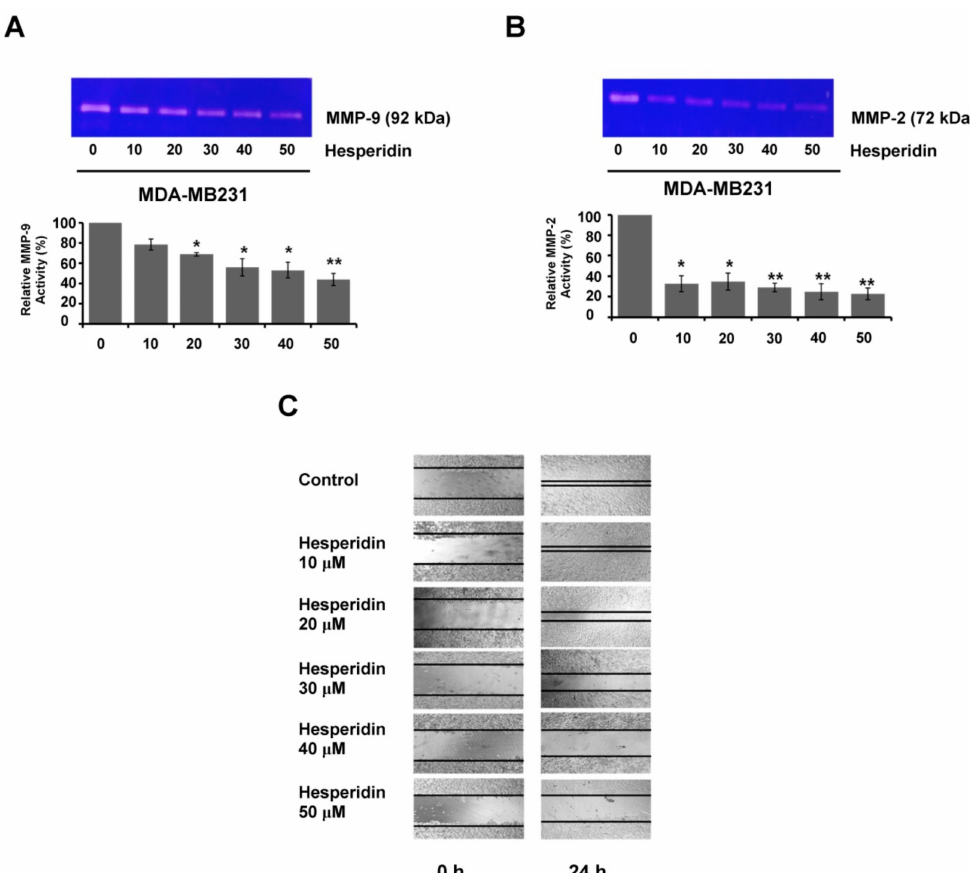
Figure 5. Hesperidin suppressed the migration and MMP secretion in PD-L1 high-expressing MDA-MB231 cells. The relative activities of ( A ) MMP-9 ( B ) MMP-2. Bar diagram represents the relative activity of MMPs in hesperidin treated groups compared to the control group considering the control value as 100 percent. ( C ) Hesperidin inhibited the migration in MDA-MB231 cells. Data indicated as mean ± SD from three individual experiments. Statistical significance * p < 0.05 and ** p < 0.01 versus control (non-treated